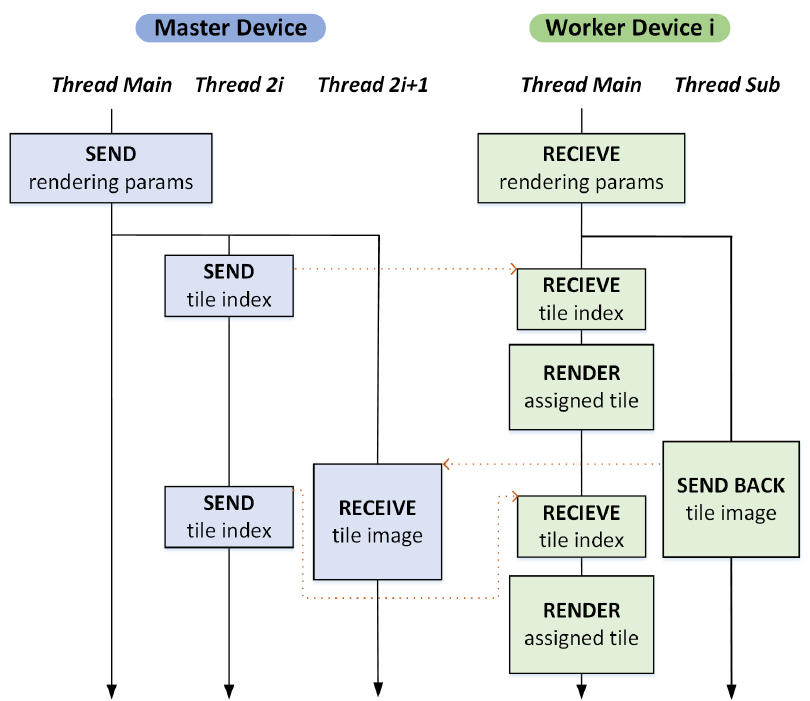
Figure 4. Master–worker interaction model I ([7]). This framework, based on dynamic load balancing, significantly improves the computational efficiency of mobile distributed rendering by separating the tasks of image transmission and GPU ray tracing in the master and worker